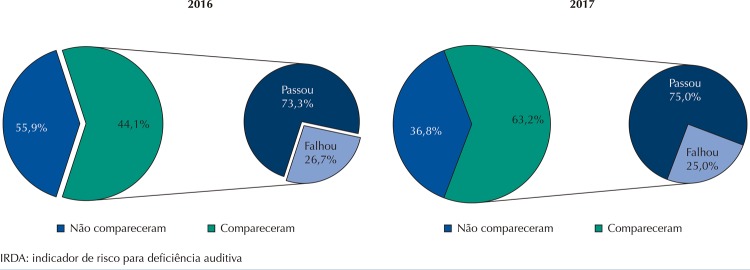
Prevalência de comparecimento, passa e falha no reteste de recém-nascidos sem IRDA nos anos de 2016 e 2017.